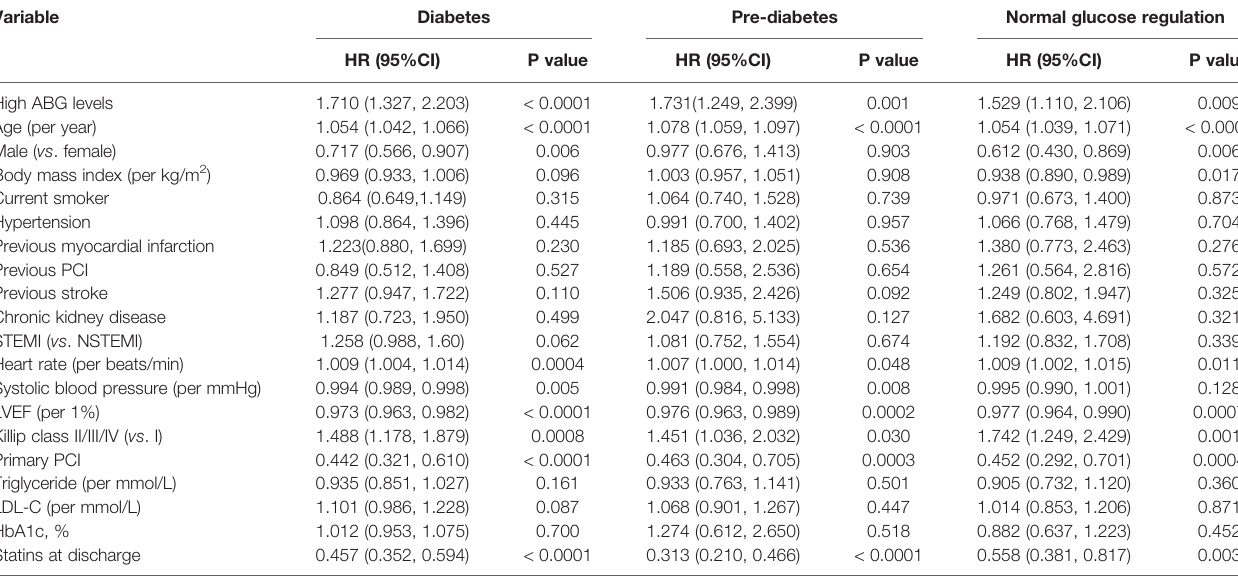
TABLE 2 | Multivariable analysis for 2-year all-cause mortality in patients with different glucose metabolism status.